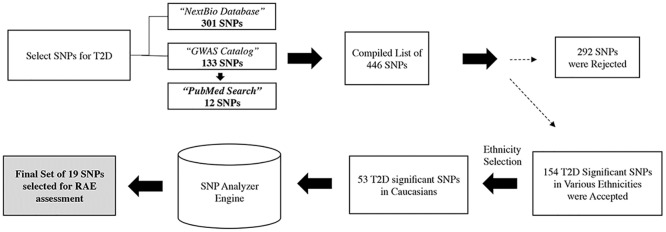
A flow diagram on how SNPs were selected for inclusion in the RAE.